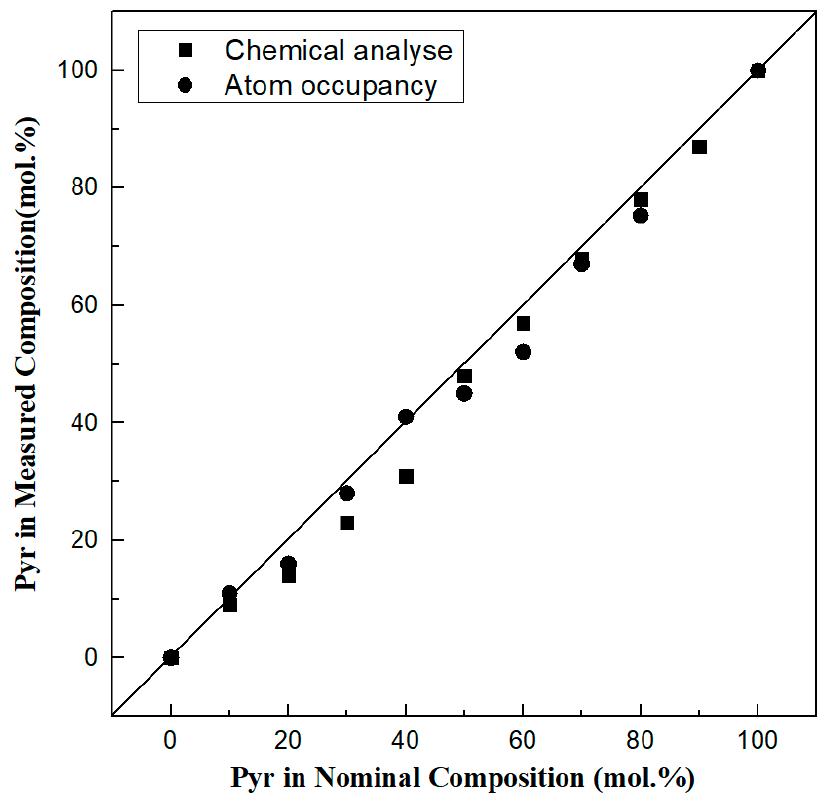
Figure 3. Relation between the measured composition and nominal composition for Alm-Pyr crystals.